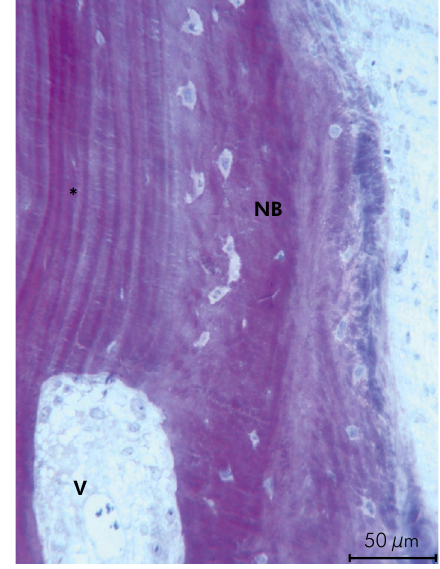
Figure 3. Group 1: inflammation and multinucleated giant cells were absent around the newly formed bone (NB) surrounding autologous bone particles (*). Blood vessels (v) were evident in the marrow spaces. (Toluidine blue and acid fuchsin, 200